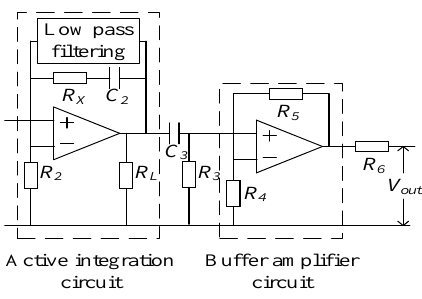
Figure 6. Optimization of integral circuit.